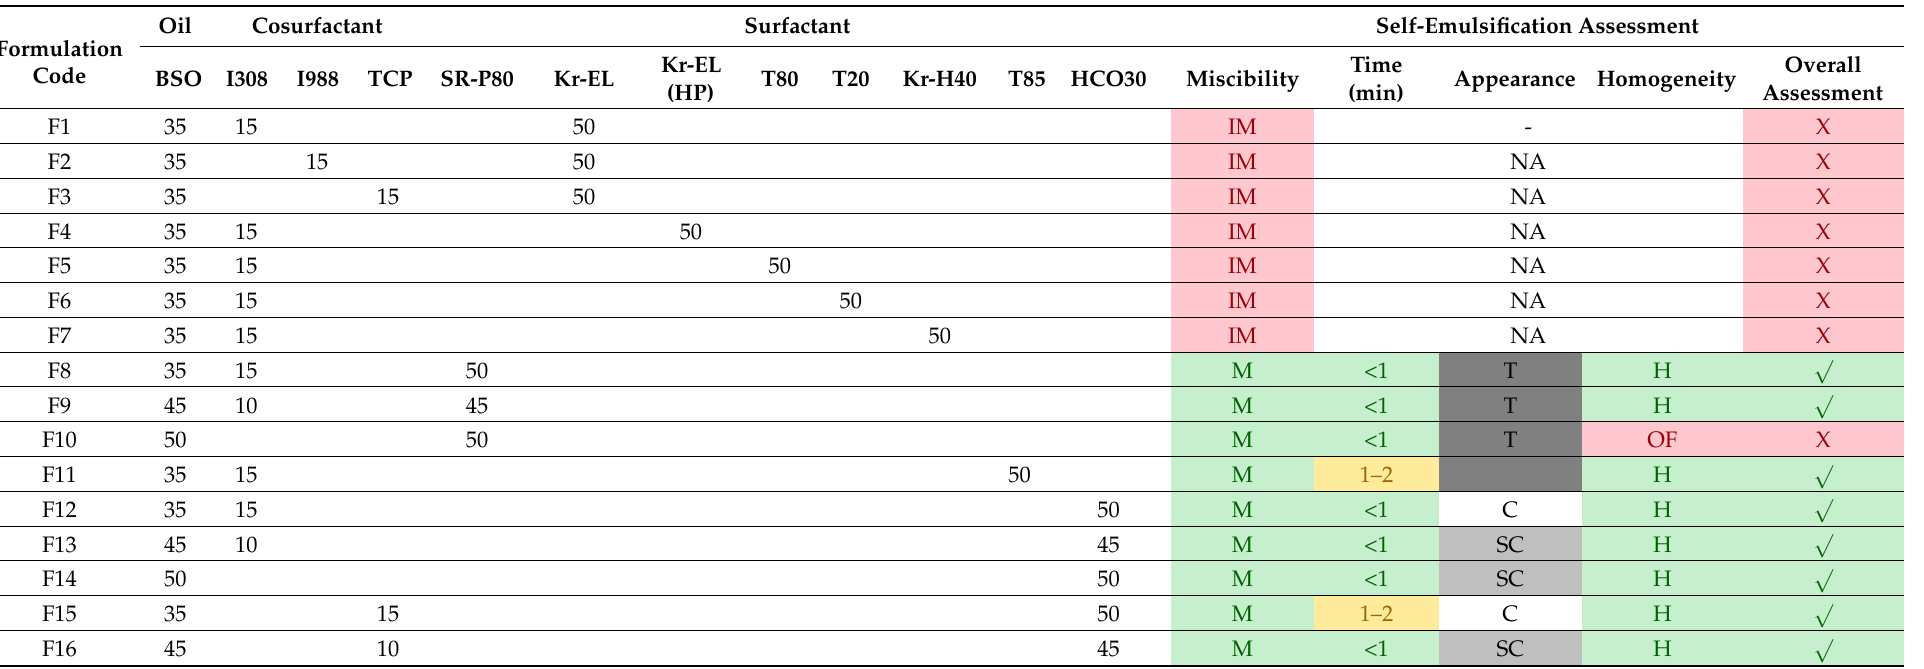
Table 1. Self-emulsification assessment of RMP/THQ-containing lipid-based